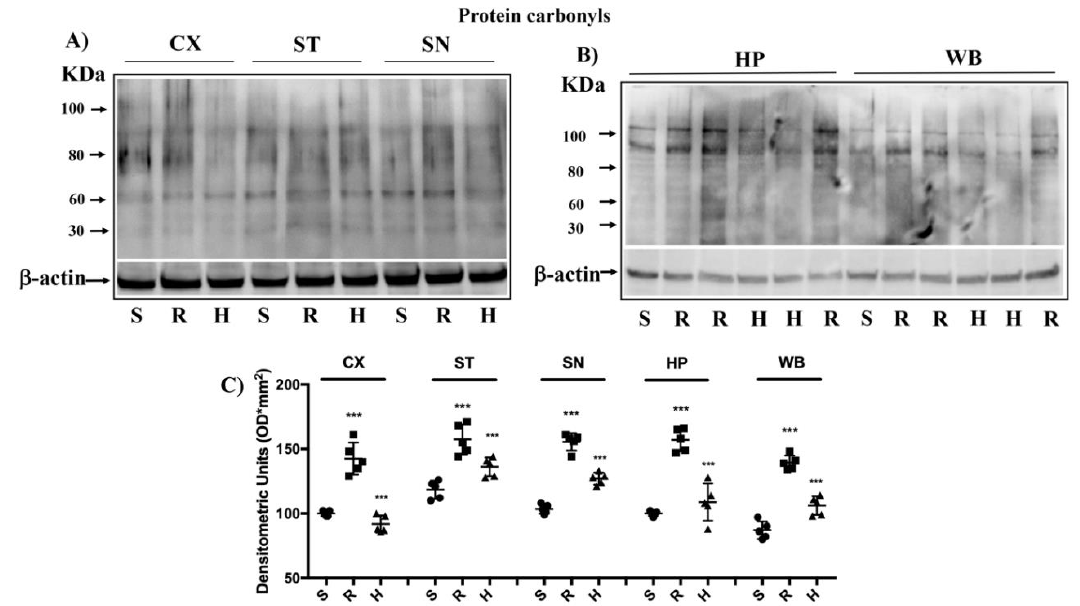
Figure 7. Brain protein carbonyls analysis after rotenone intoxication. ( A , B ) The examination of the carbonyls of brain proteins showed a significant increase of these in all brain regions examined after induction of rotenone (R), compared to the control (S) and animals treated with HD (H). The data are expressed as mean ± SEM from N = 5 mice/group. ( C ) *** p < 0.001 vs. Sham; *** p < 0.001 vs. rotenone.